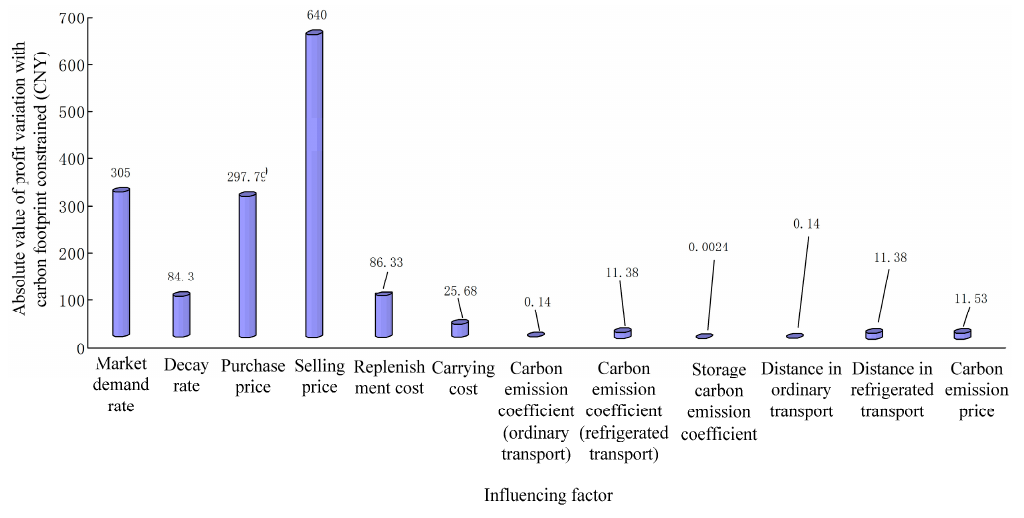
Figure 3. Absolute value of profit variation with carbon footprint constraint in different influencing